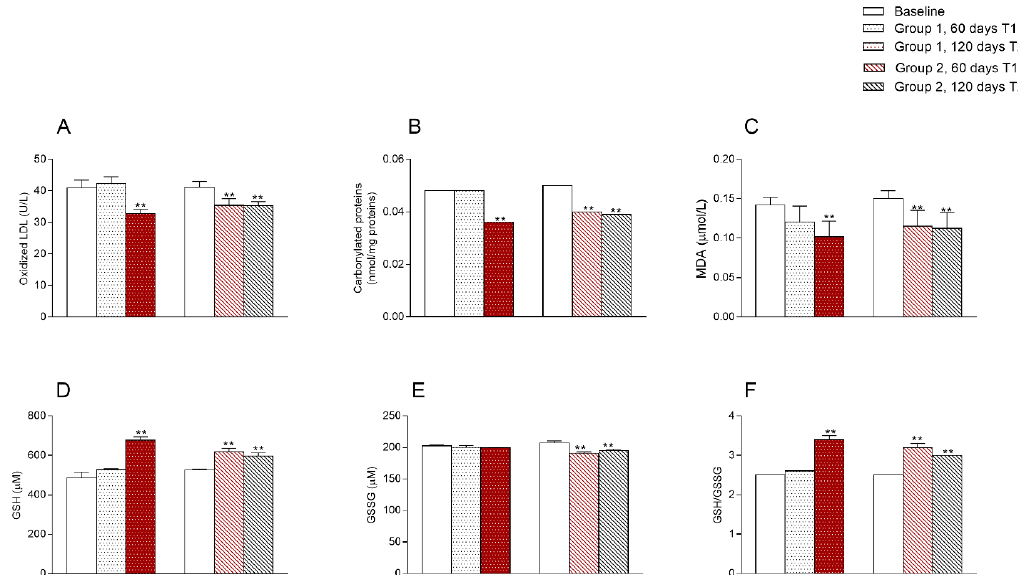
Figure 2. Changes in oxidative stress markers at 60 and 120 days compared to baseline. White = RCR, Red = RCR + tomato; Serum levels of ( A ) oxidized low-density lipoprotein (LDL); ( B ) carbonylated proteins (PC), ( C ) malondialdehyde (MDA); ( D–E ) reduced (GSH) and oxidized glutathione (GSSG) and ( F ) GSH to GSSG ratio. ** p < 0.01 paired Student’s-test comparing the effect of each intervention to the baseline. Oxidized LDL and carbonylated proteins were significantly reduced in both groups over tomato supplementation (Figure 2A–B). MDA decreased in both groups at T1 compared to T0 (Figure 2C) (−23% p = 0.000 for RCR + Tomato group, –15% p = 0.000 for RCR group), GSH increased and GSSG decreased in group 2 (RCR + Tomato), both at T1 and T2, compared to baseline values (Figure 2D–E). Consequently, GSH/GSSG ratio increased in group 2 at both time points (Figure 2F). In group 1 (RCR) GSH and GSH/GSSG ratio increased only at T2 (after RCR + Tomato) compared to baseline values, whereas GSSG did not change (Figure 2D–F).